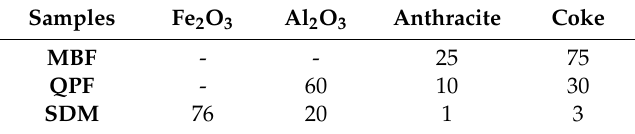
Figure 1. Schematic diagram of monomer blended fuel (MBF), quasi-granular fuel (QPF) and sintered mixture (SDM). Table 2. Raw materials and proportions used in the experiment, wt%.